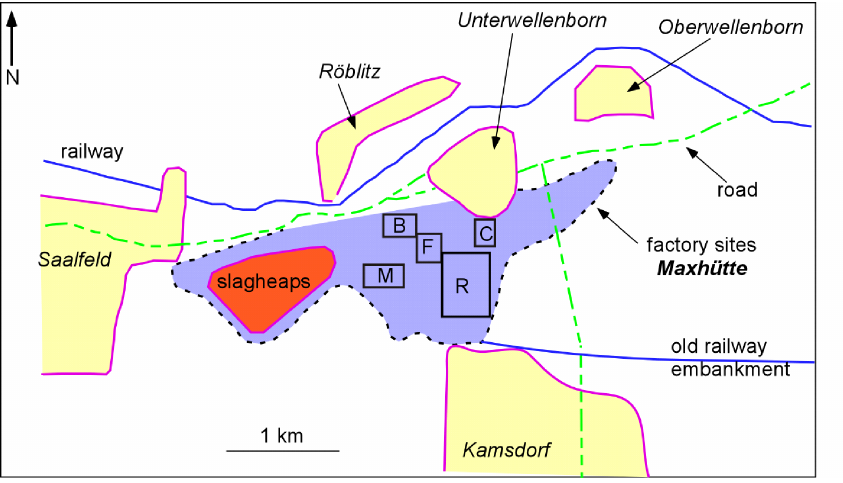
Fig. 1 Territorial location of the sampling region. The letters indicate the different industries in the region: M – steel factory; F – foundry; B – blast furnace; R – rolling mill factory; C – cement factory. The colors indicate different sampling areas: blue area – factory sites; yellow – urban and rural sites; green – streets; blue lines – railway; orange line – fields; the black boxes – industry